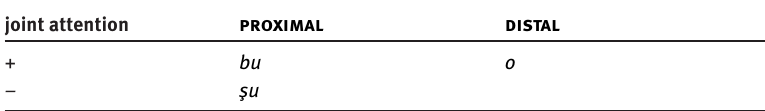
Table 5: Turkish demonstratives joint attention proximal distal